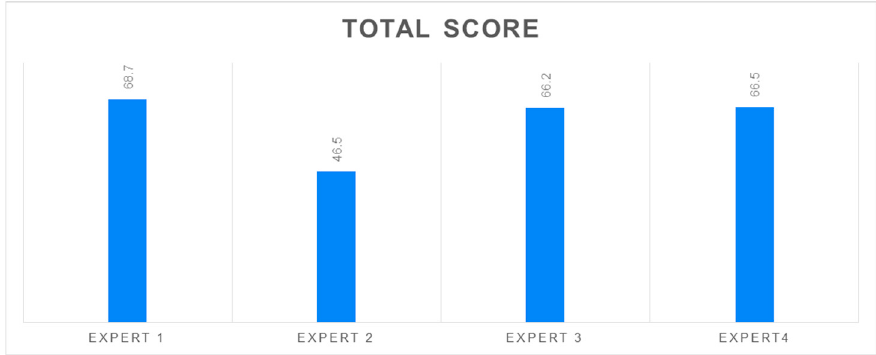
Figure 5. The total scores of Building Complex III given by four different experts.